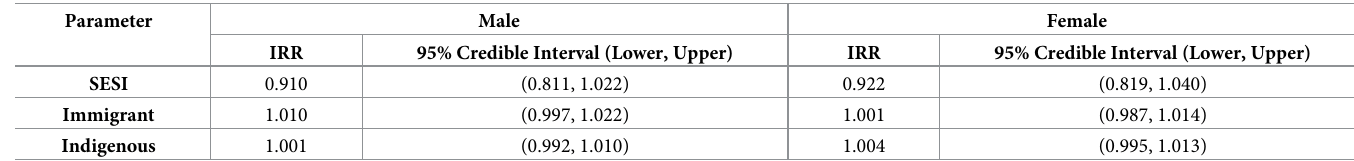
Table 5. Incidence Risk Ratio (IRR) and 95% credible interval for Non-cardia GC dataset stratified by sex using spatial Poisson regression model. Parameter